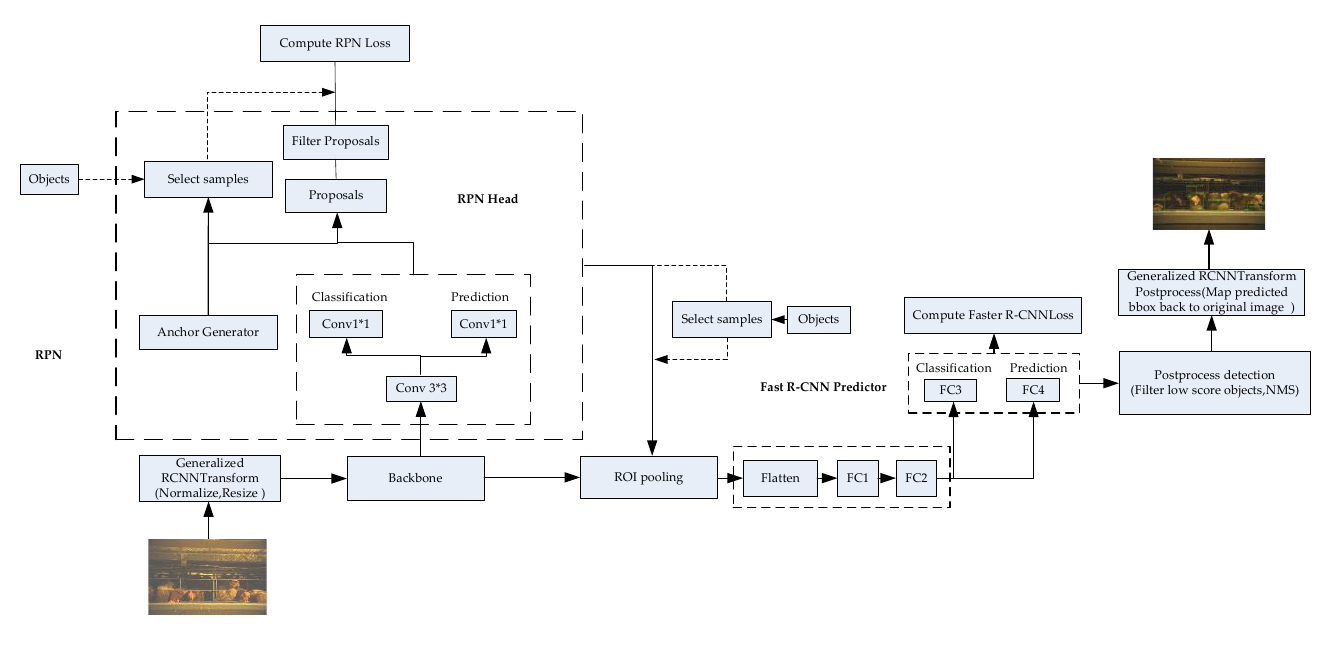
Figure 3. S tructure of Faster R-CNN network. FC: fully connected layer, Conv: convolution. Figure 3. Structure of Faster R-CNN network. FC: fully connected layer, Conv: